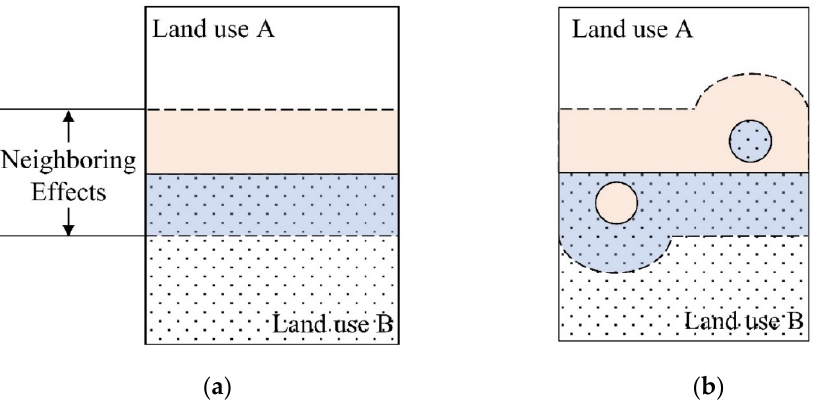
Figure 1. Illustrations of the neighboring effects and impacts of fragmentation. ( a ) Simple adjacent relationship; ( b ) an example of the complex adjacent relationship caused by landscape fragmentation.